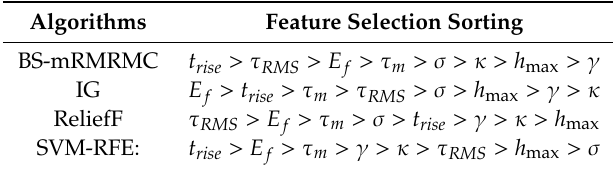
Table 2. Feature selection ranking of four